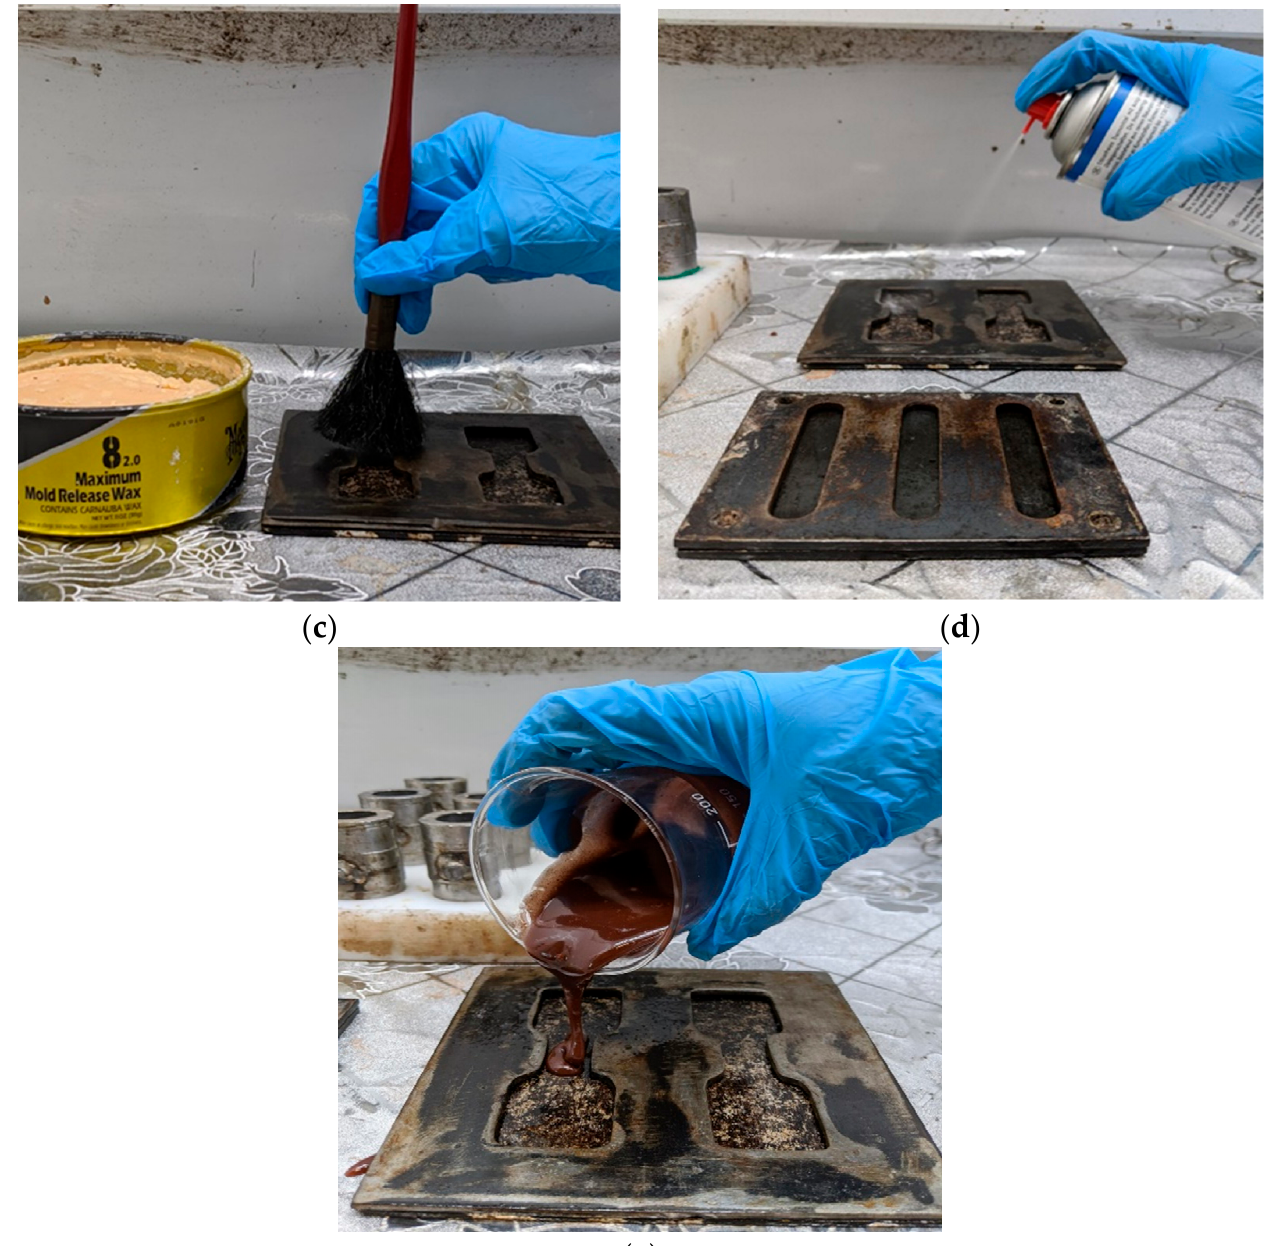
Figure 2. ( a ) A particular amount of BR was gradually added to the UPR resin; ( b ) when the mixture became homogenous (after approximately 5 min), MEKP was added to the mixture for the thermosetting process ( c ) the inner surface of three types of stainless-steel molds was coated with paraffin wax ( d ) and polyvinyl acetate to prevent the sample from sticking to the mold; ( e ) the mixture was poured into the molds.